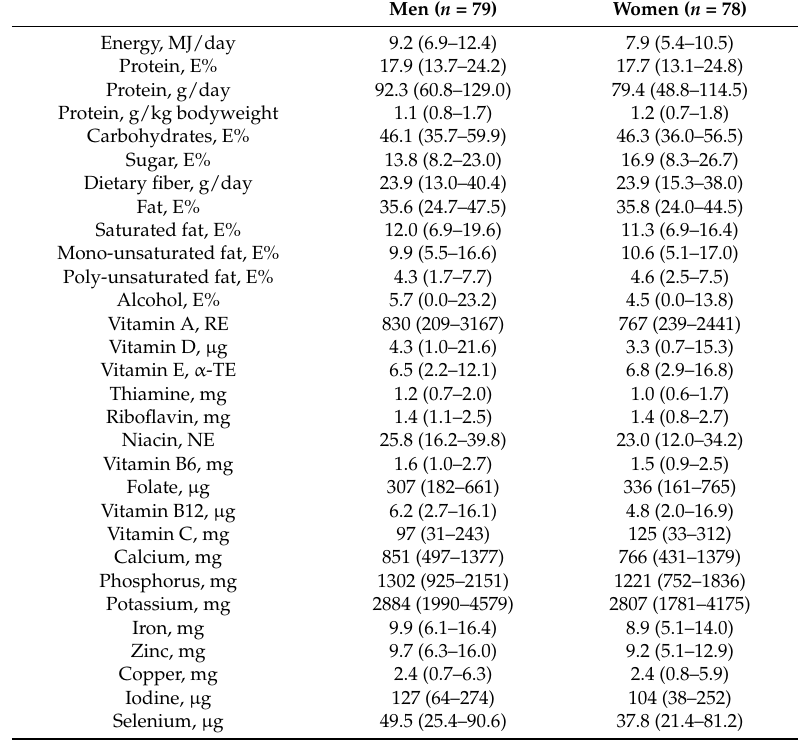
Table 2. Daily intake of nutrients in the ‘Counteracting Age-related Loss of Skeletal Muscle Mass’ (CALM) population (values are presented as medians and